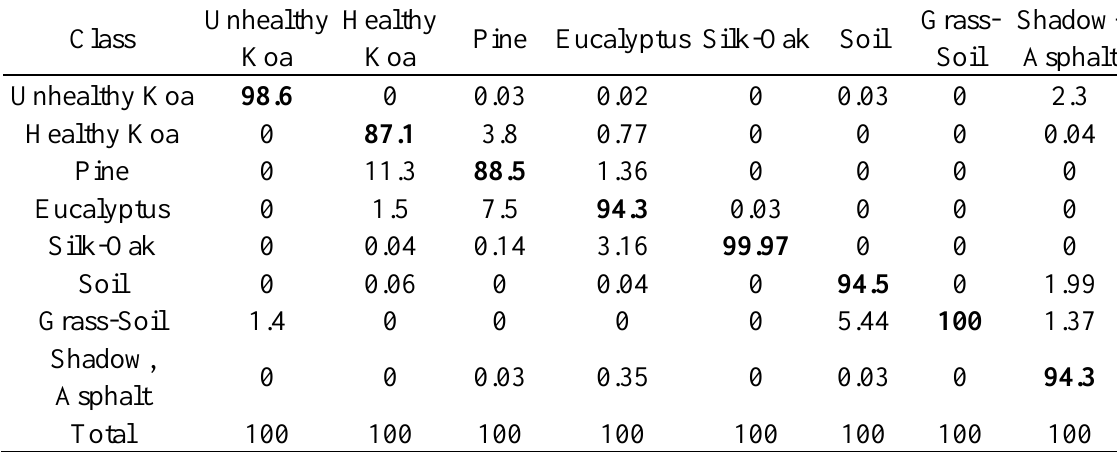
Table 1. Assessment of class overlap among cover classes. Numbers in bold represent the particular class to which the greatest percentage of pixels in the testing site were classified. Columns add up to